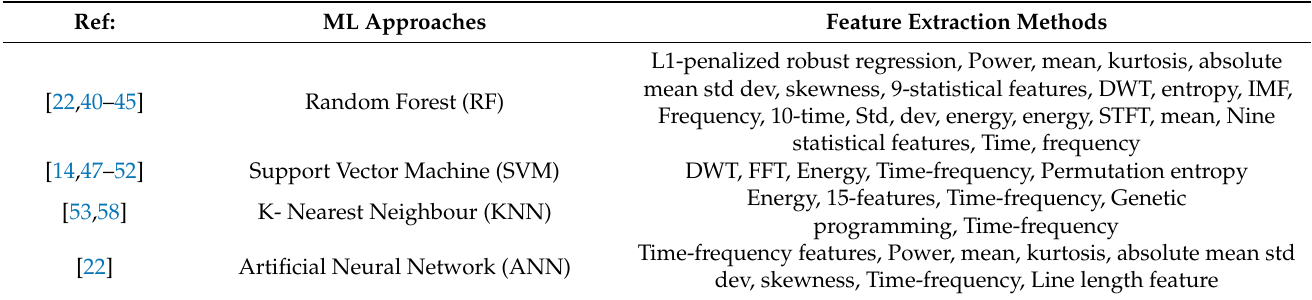
Table 10. A review of recent research that applied the ML approach for seizure